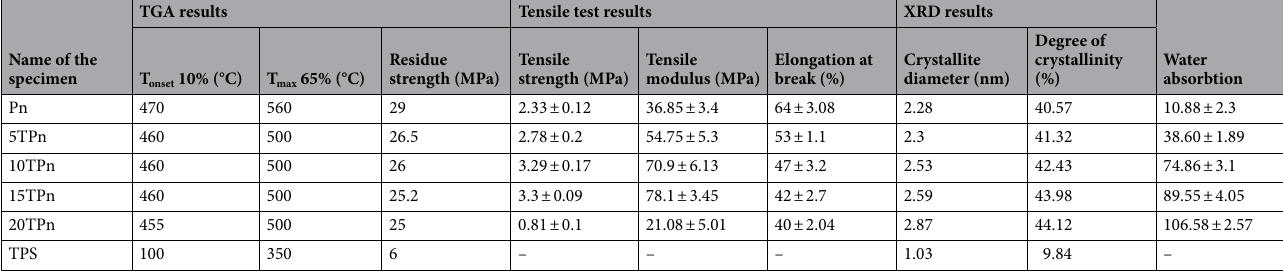
Table 1. TGA, tensile, XRD, and water absorption data of TPS/PVDF nanofibers.